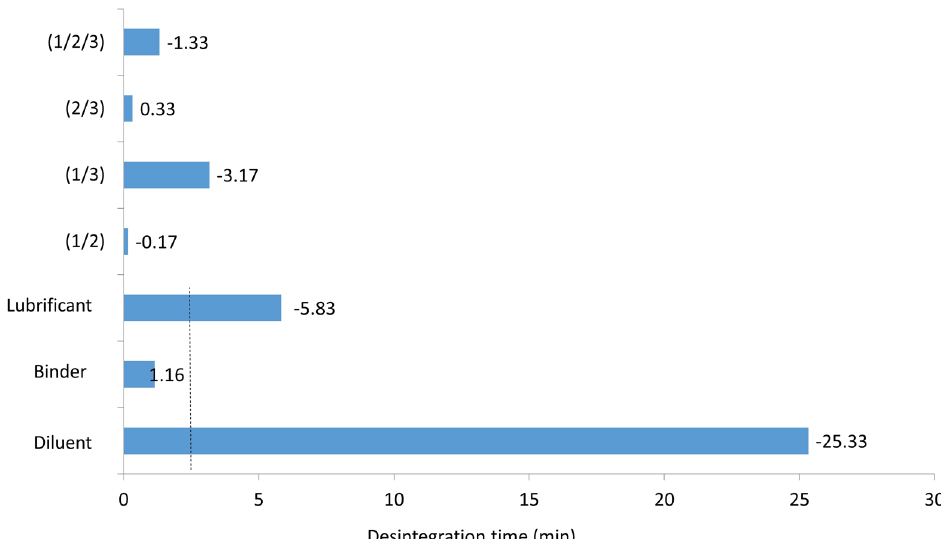
FIGURE 3 - Pareto Graph for factorial planning 2 3 results, considering the effects produced in the disintegration time. Dashed line defines 95% confidence interval. Interaction of parameters 1 and 2 (1/2); Interaction of parameters 1 and 3(1/3); Interaction of parameters 2 and 3 (2/3); and Interaction of parameters 1, 2 and 3